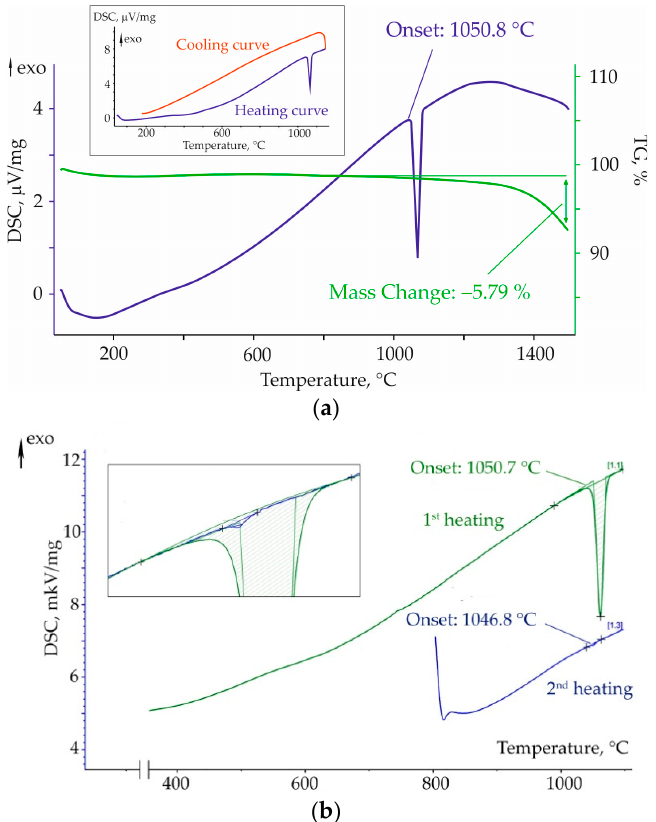
Figure 5. TGA-DSC curves of Yb:YMBO compound: ( a ) data collected in the temperature range of 50–1500 ° C and ( b ) repeated heating in the temperature range 50–1100 ° C.